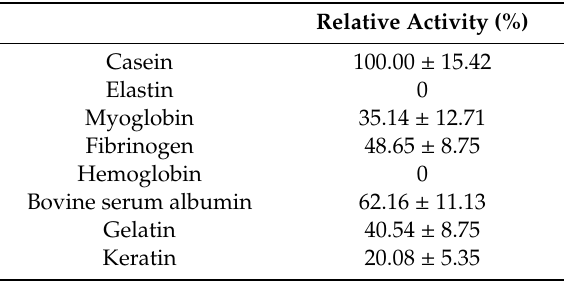
Table 3. Substrate specificity of the P. mucilaginosus TKU032 protease.